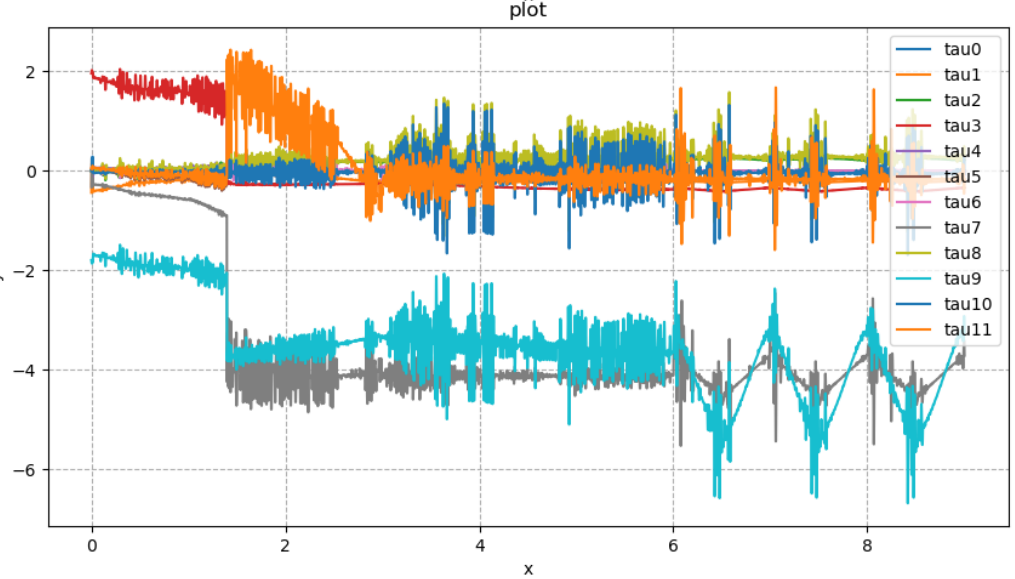
Figure 13. When Roban’s COM moves 5 cm, it completes three squats on a single leg. The torque feed forward diagram is required by Roban in this process.